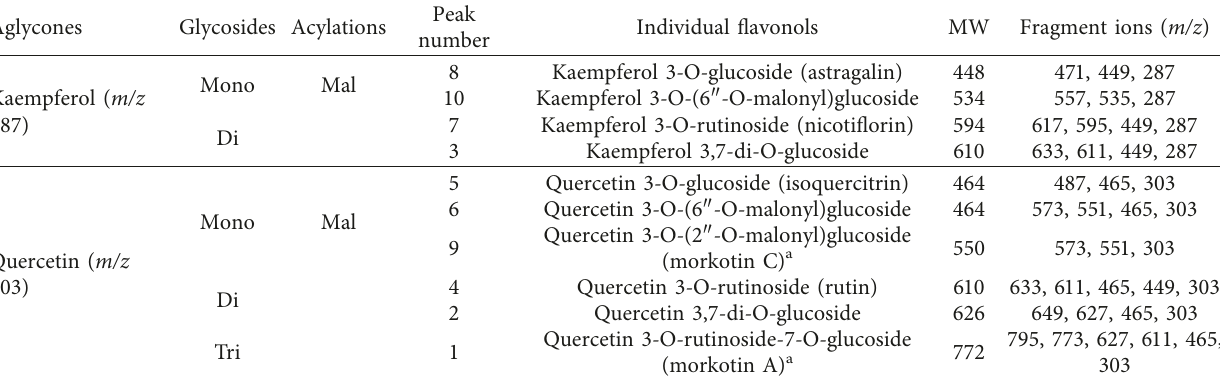
Table 1: Ten flavonoids isolated from Korean mulberry fruits ( Morus alba L.) and their mass spectrometric data. Aglycones Glycosides